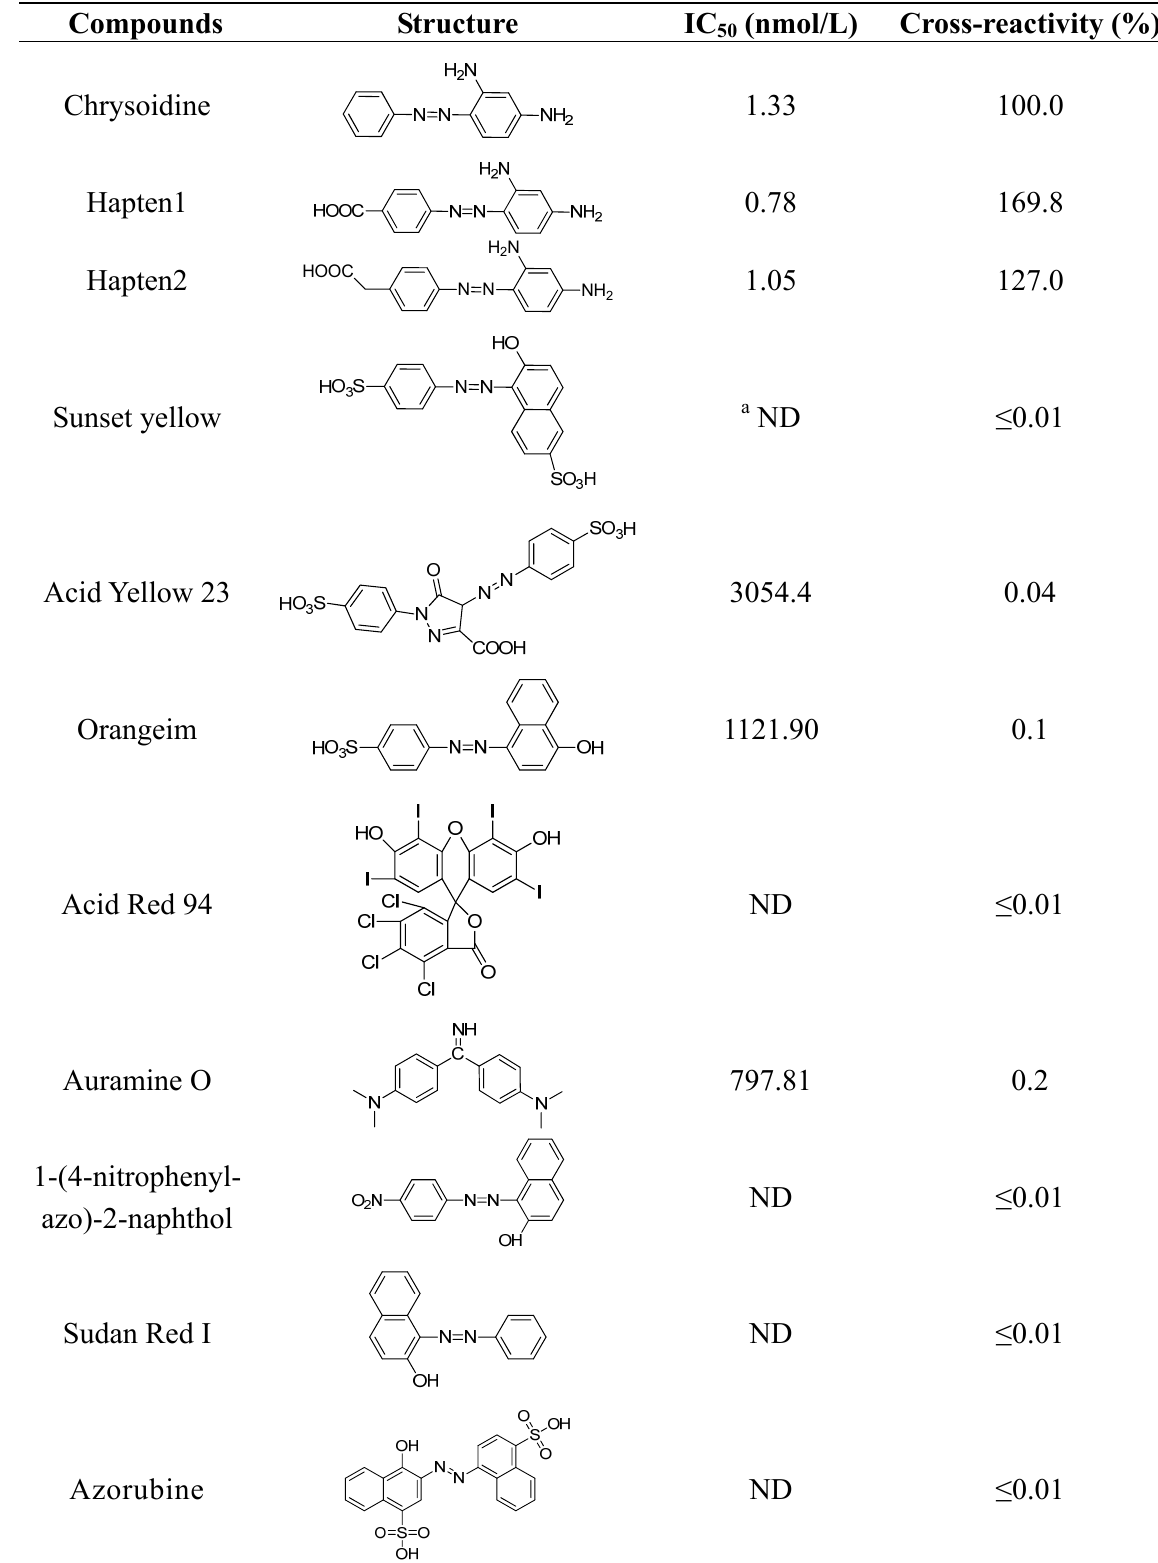
Table 2. Cross-reactivity of the polyclonal Ab 2 with chrysoidine, hapten and other compounds based on coating antigen Hapten